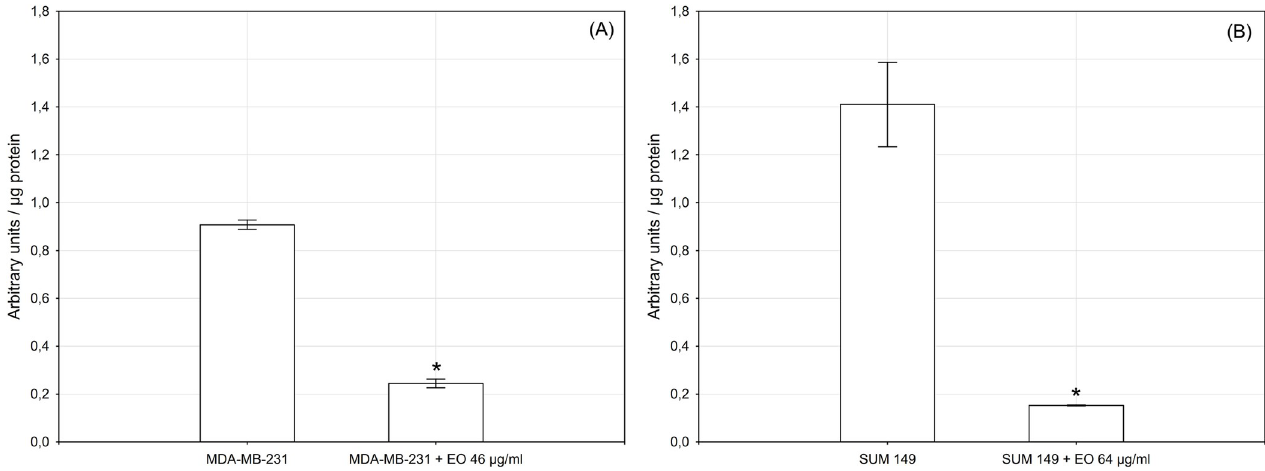
Fig 3. NF- κ B (p65 subunit) DNA binding capacity in nuclear extracts of MDA-MB-231 cells (A) and of SUM 149 cells (B). The cells were treated for 24 h with C . juttae essential oil (EO) (46 and 64 μ g/ml, respectively). Results (mean ± standard error of two experiments carried out in duplicate) are expressed as arbitrary units/ μ g protein of cells nuclear extracts. Statistical differences are � p < 0.05 vs. control.